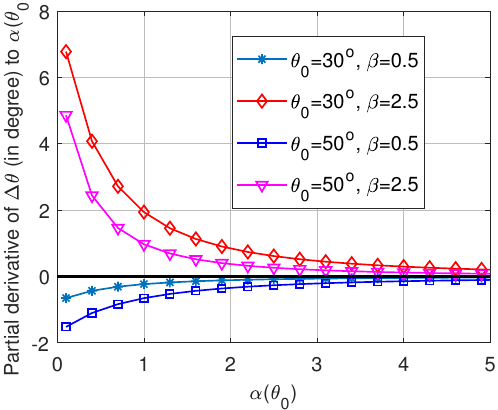
Figure A2. The partial differential of DOA estimation error ( ∆ θ ) to α 1 ( θ 0 ) for different combinations of β and θ 0 . The thick black horizontal line indicates the partial derivative being equal to